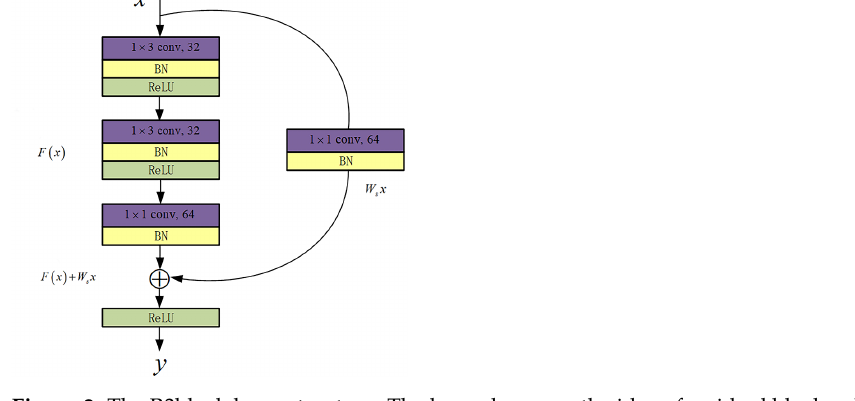
Figure 2. The R3block layer structure. The layer draws on the idea of residual block, which is used to fuse the features of neighboring points around the centroids